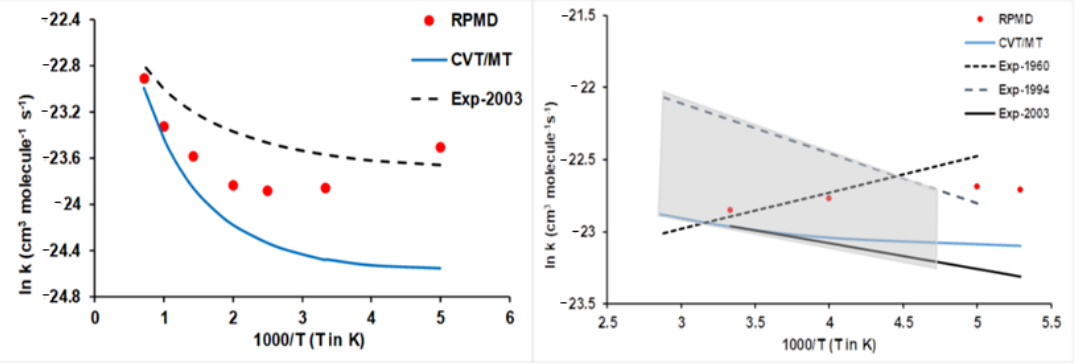
Figure 8. Arrhenius plots of the Cl( 2 P) + C 2 H 6 ( left panel ) and F( 2 P) + C 2 H 6 ( right panel ) thermal rate constants (cm 3 molecule − 1 s − 1 ). Blue line: CVT/MT rate constants; red circles: RPMD rate constants. In the left panel, black dashed line: experiment from Ref. [86]. In the right panel, the experimental values 1960, 1994, and 2003, from Refs. [87–89], respectively.